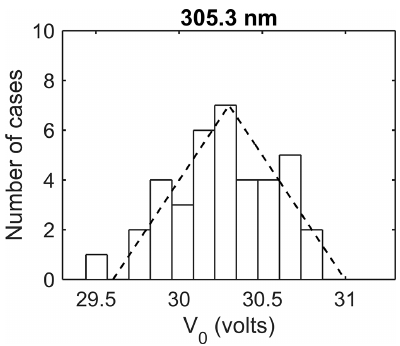
Figure 3. Frequency distribution of V 0 for the 305nm channel de- rived with the refined Langley plot method (Eq. 3) during both cal- ibration periods, 2015 and 2016, at Izaña. The results were approx- imated with a triangular distribution indicated by the dashed